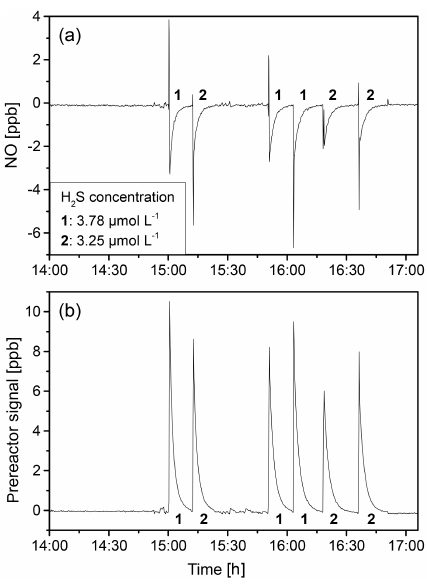
Figure 2. Detector signal for six seawater samples containing H 2 S. (a) Signal passing the prereactor. (b) Prereactor